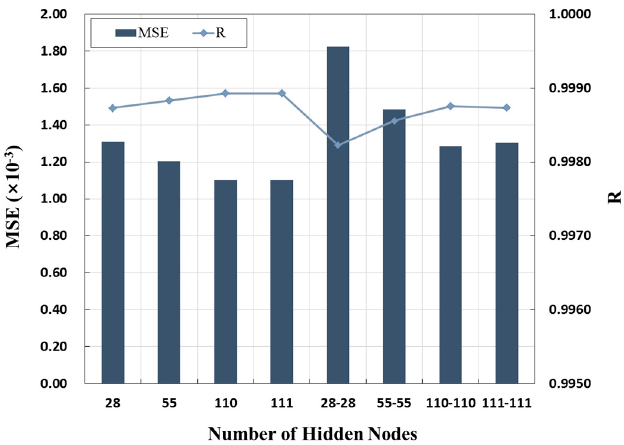
Figure 9. Training results by ANN structure.